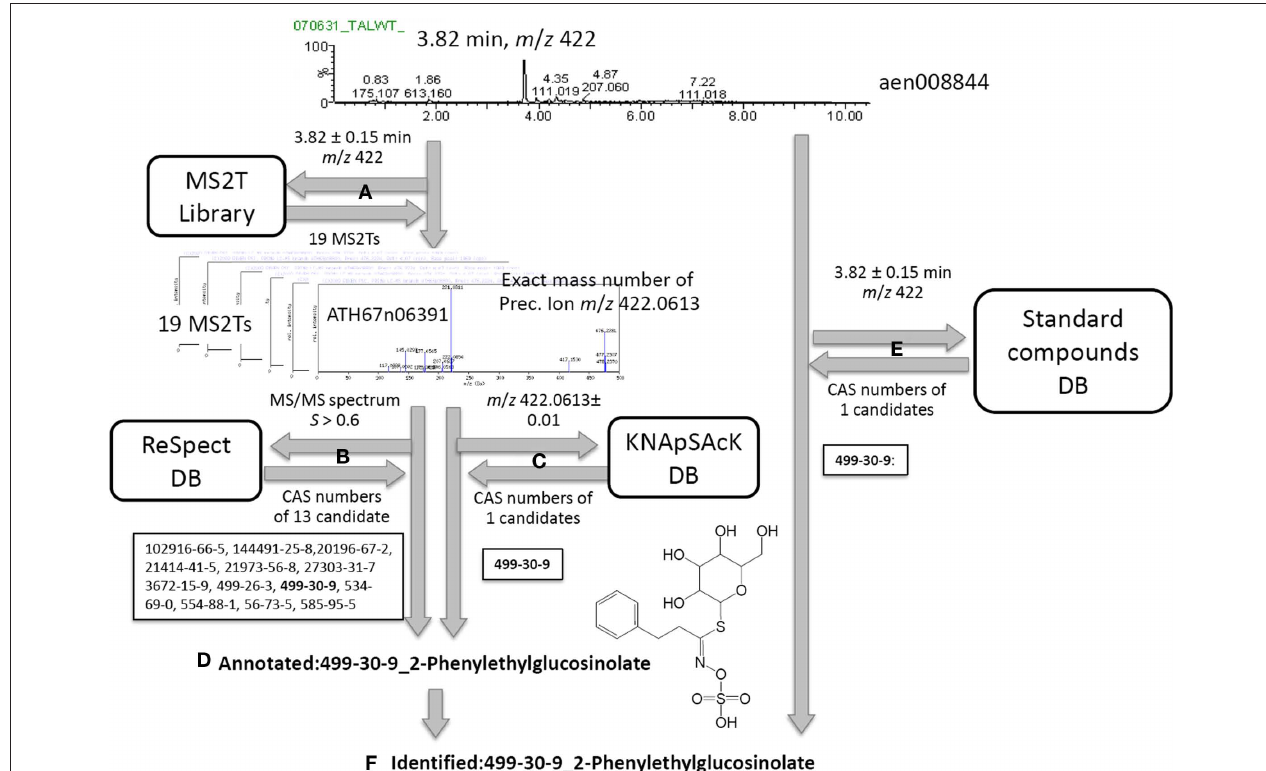
Figure 2 | Procedure for peak identification and putative annotation using CAS identifiers. For the case of a metabolite signal, aen00884, the MS2T library contains 19 MS2T accessions acquired from the identical metabolite signal (A) . MS/MS spectra data in MS2T were submitted to the ReSpect database (B) . The exact mass number data of the precursor ion was used to search the KNApSAcK database (C) . Since a common CAS number (499-30-9,